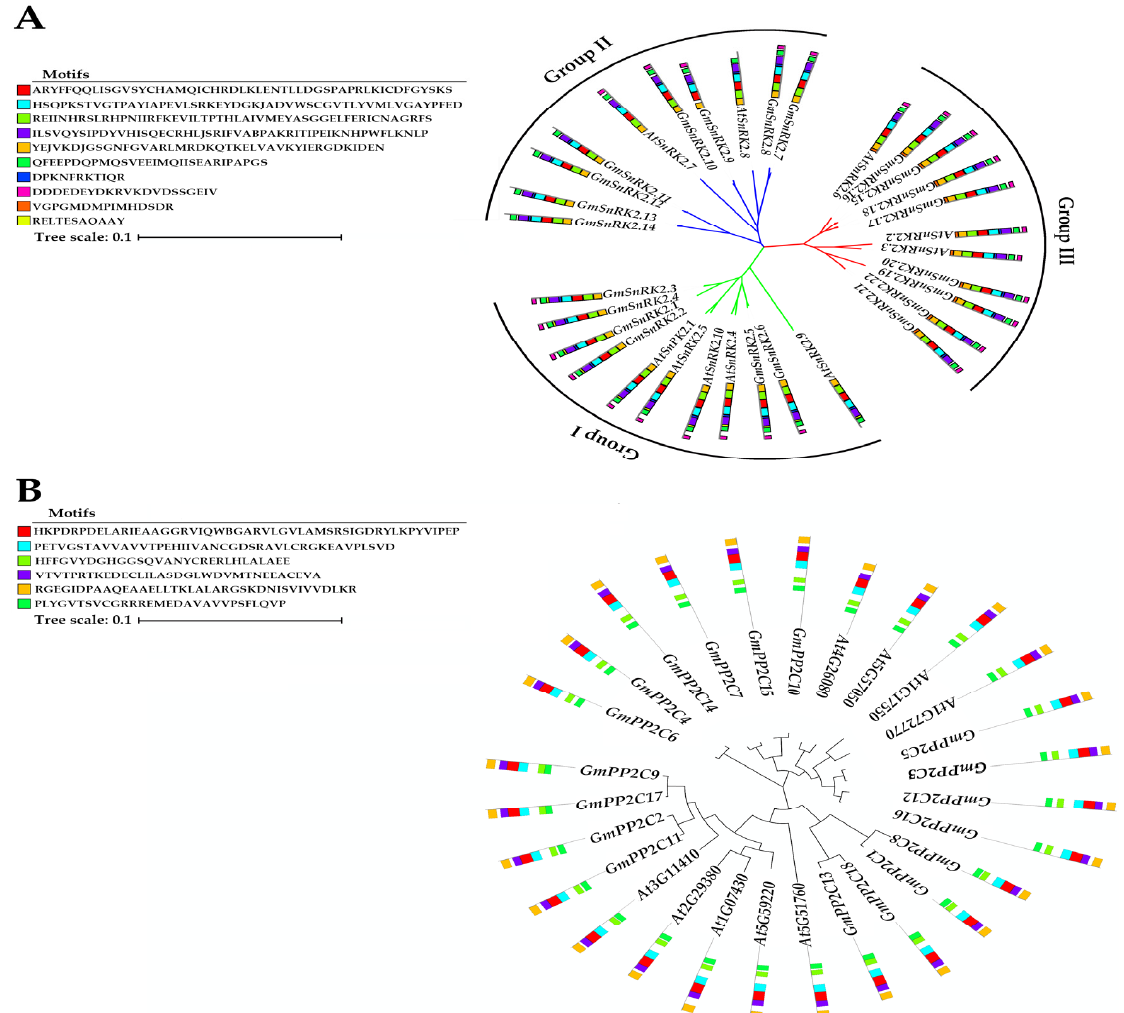
Figure 2. Phylogenetic analysis and distribution of the conserved motifs in GmSnRK2s and GmPP2C- As . ( A ) Phylogenetic relationships and conserved motifs in GmSnRK s and AtSnRK2s. ( B ) Phylogenetic relationships and conserved motifs in GmPP2C-As and AtSnRK2s . The ML phylogenetic tree shown was constructed via full-length protein sequences and with 1000 bootstraps. The conserved motifs were detected using MEME software and are represented by coloured boxes. Gm = G. max and At = A. thaliana